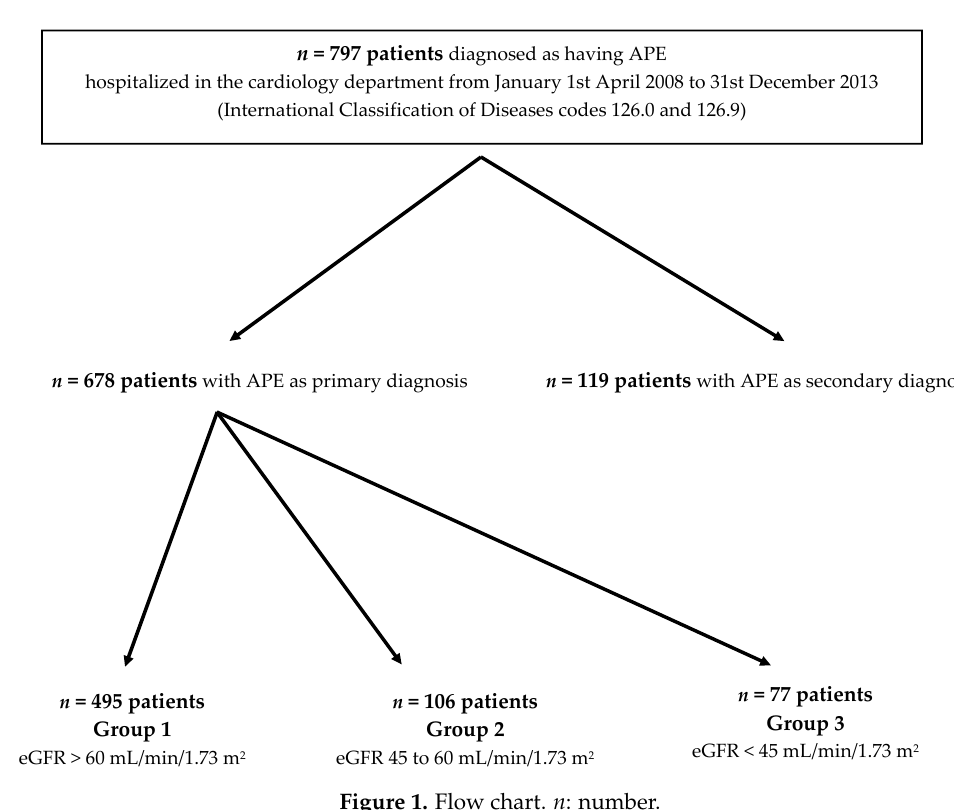
Figure 1: Flow Chart